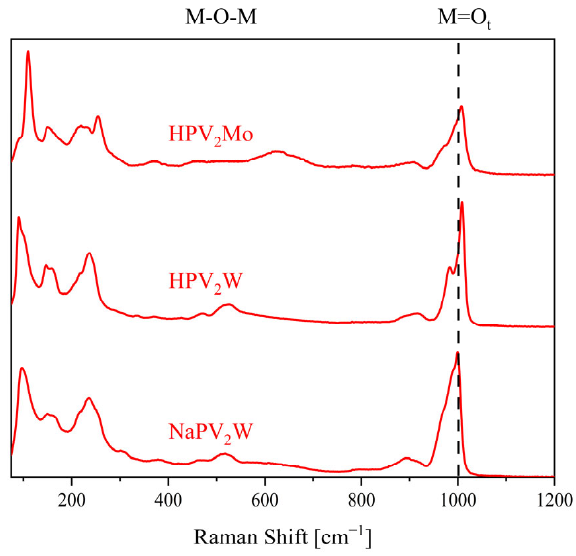
Figure 4. Raman spectra of the POMs NaPV 2 W, HPV 2 W, and HPV 2 Mo. The black line runs through the peak maximum of an M = O t vibration band from NaPV 2 W, to illustrate the trend of the peak shift dependence on the substitution degree.